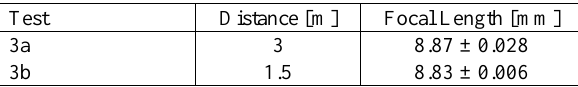
Table 3 Focal length values at different distances Figure 8, Figure 9 and Figure 10, the radial distortions have a “barrel” shape.